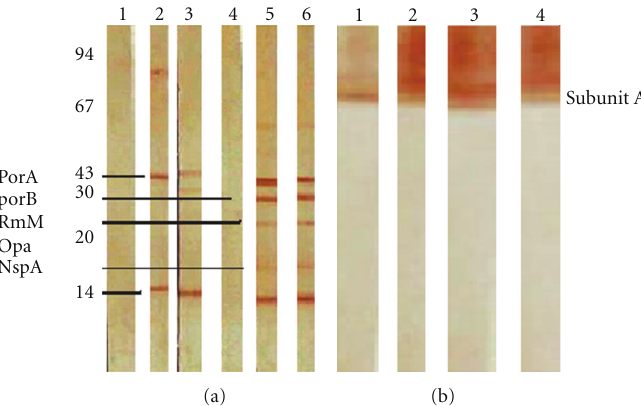
Figure 6: Immunoblot reactivity showing IgG antibodies binding to OMPs of N. meningitidis . (a)(1)–(6) With OMPs of N. meningitidis (B: 4:P1 . 15,19,5.5,L379,1,8) 28 days after i.n. immunization in the presence of stx1 (a)(1) or stx2 (a)(2). Immunization-specific IgG antibody responses at 42 days, 7 days post the i.m prime-boost in the presence of stx1 (a)(5) and stx2 (a)(6) as adjuvants in serum. Immunoreactivity of normal sera used as a control in (1,4). In (b)(1,2), immunoblot with sera of BALB/c mice immunized with OMPs and toxoids. IgG reactivity with (1) OMPs and stx1 28 days after i.n. immunization (2) OMP and stx1 42 days, 7 days post the i.m prime-boost and (b)(3,4) immunoblot with sera of BALB/c mice immunized with OMPs and toxoids. IgG reactivity with (1) OMPs and stx2 28 days after i.n. immunization (2)